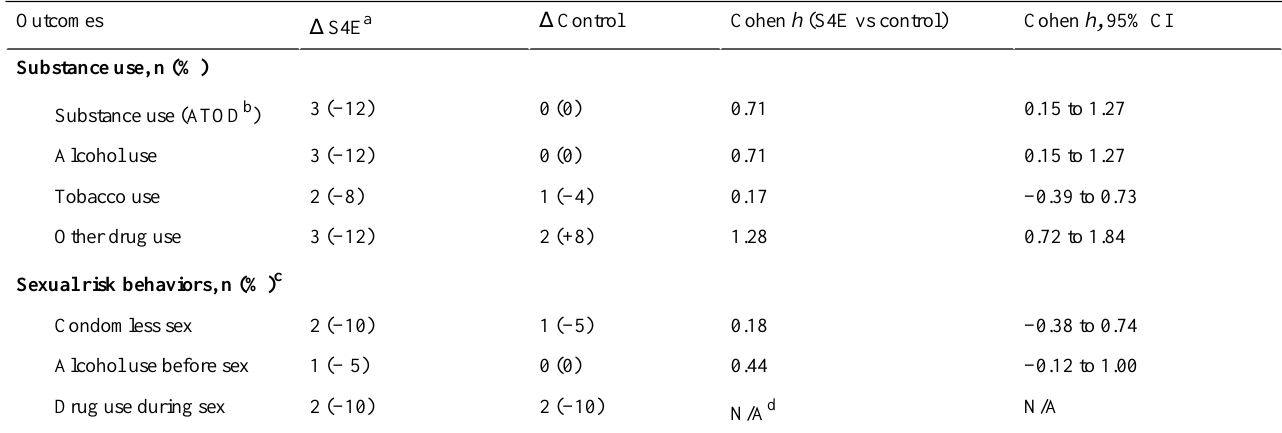
Table 4. Past 30-day behavior outcome proportion change scores by